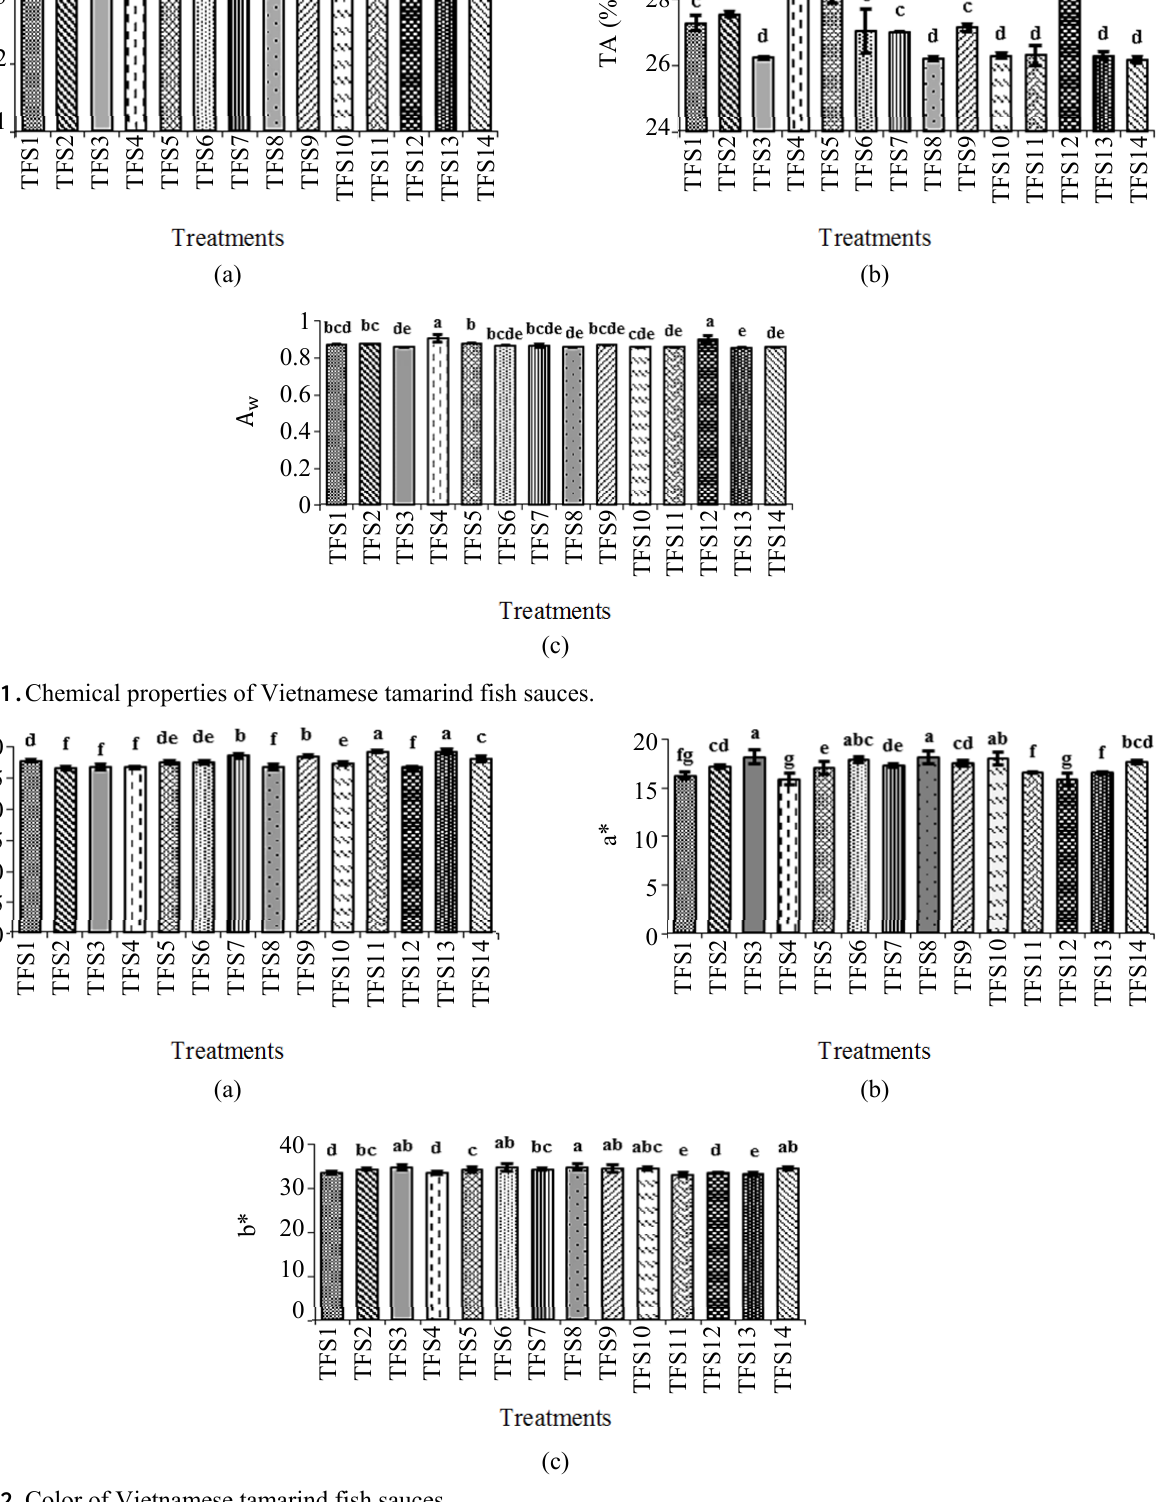
Fi g. 2. Color of Vietnamese tamarind fish